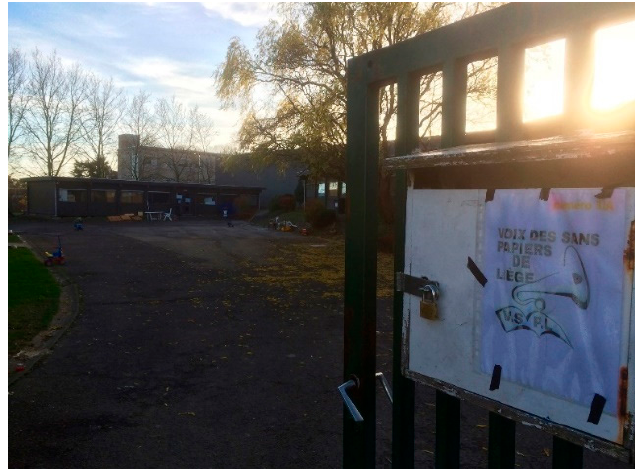
Figure 1. The buildings inhabited by the members of the collective © La Voix des Sans-Papiers de Liège, Facebook